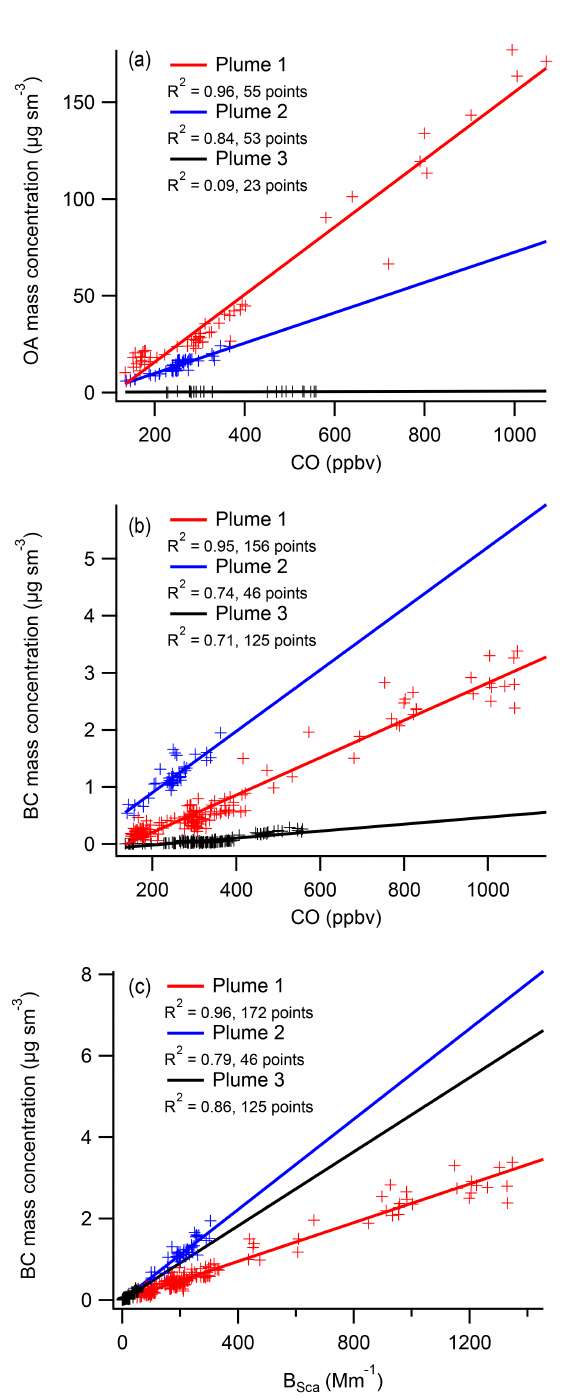
Figure 3. Correlations of (a) OA / CO, (b) BC / CO and (c) BC /B Sca in the three plumes. The slopes (which were calcu- lated by orthogonal distance regression) are listed in Table 1 for (a) and (b) and Table 3 for (c) . The peak OA concentration in Plume 3 was 1 . 4µgsm − 3 .